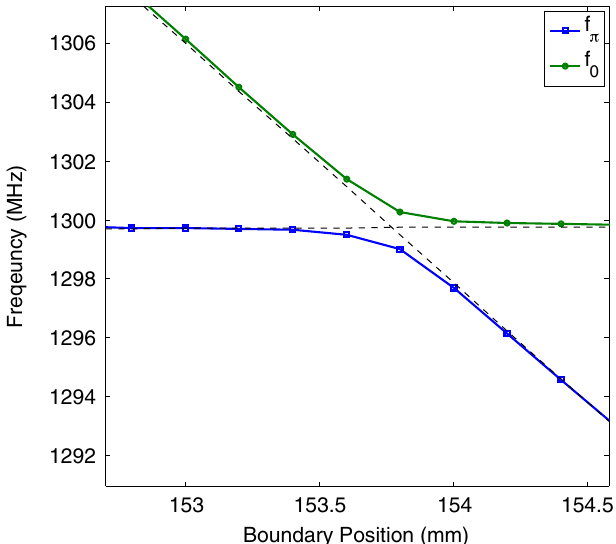
FIG. 3. Frequency of 0 and (cid:4) modes in coupler region vs coupler